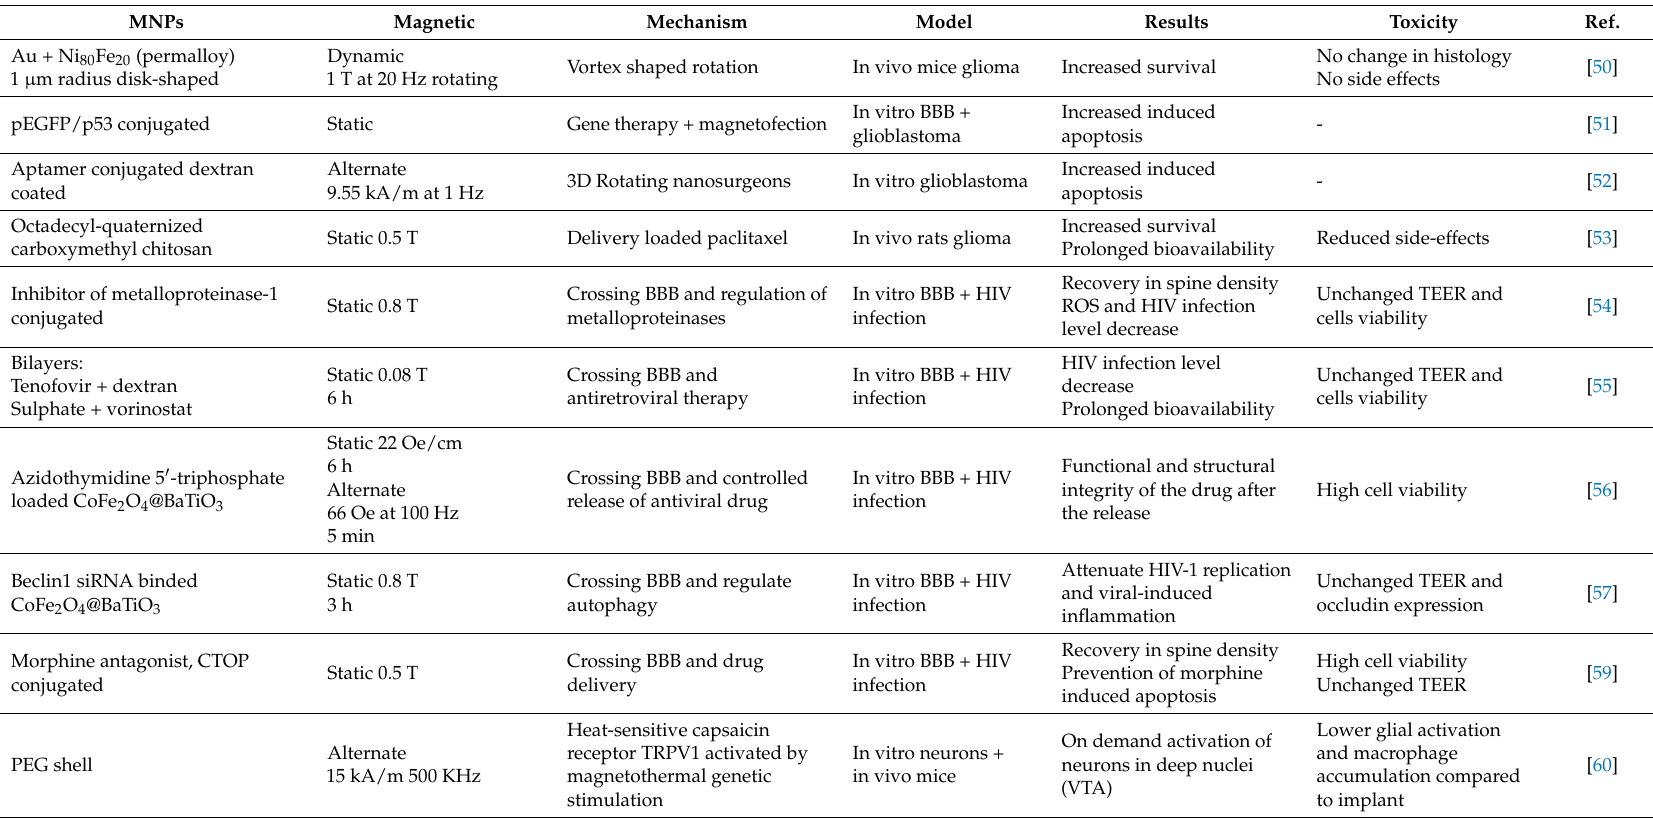
Table 2. MNPs biomedical